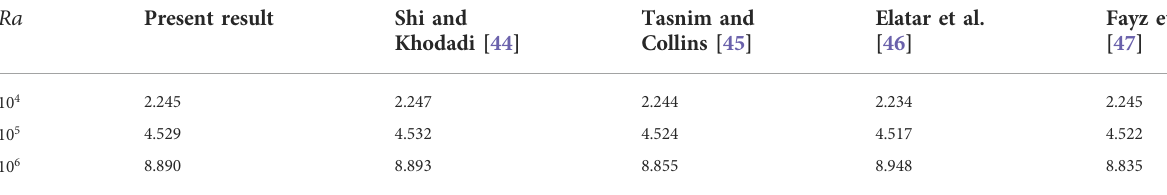
TABLE 5 Comparison of results with the published literature by measuring the Nusselt number.